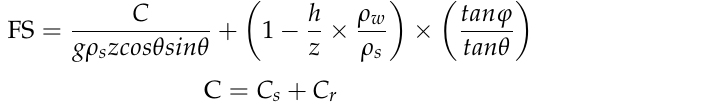
Table 1. The parameter values used for different LULC of the study area.